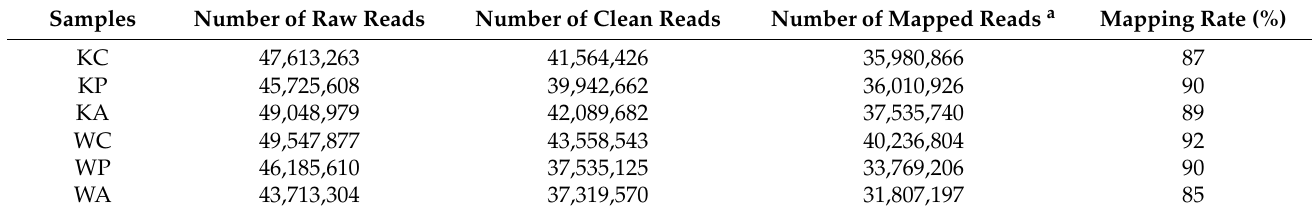
Table 1. Summary of transcriptome sequencing and